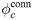
Spatial correlations increase connectivity but have little effect on cluster size distribution.(A) Connectivity, defined as probability that a connected path of on-cells exists, occurs at lower on-cell fraction ϕ as correlation parameter ρdiv increases (N = 103 lattices). (B) Connectivity threshold ϕcconn, defined as ϕ value for which connectivity is 50%, decreases with ρdiv (N = 103 lattices). (C) Spatial correlations (ρdiv = 0.38) have little effect on distribution, in particular not removing exponential rolloff at large n (N = 103 lattices).